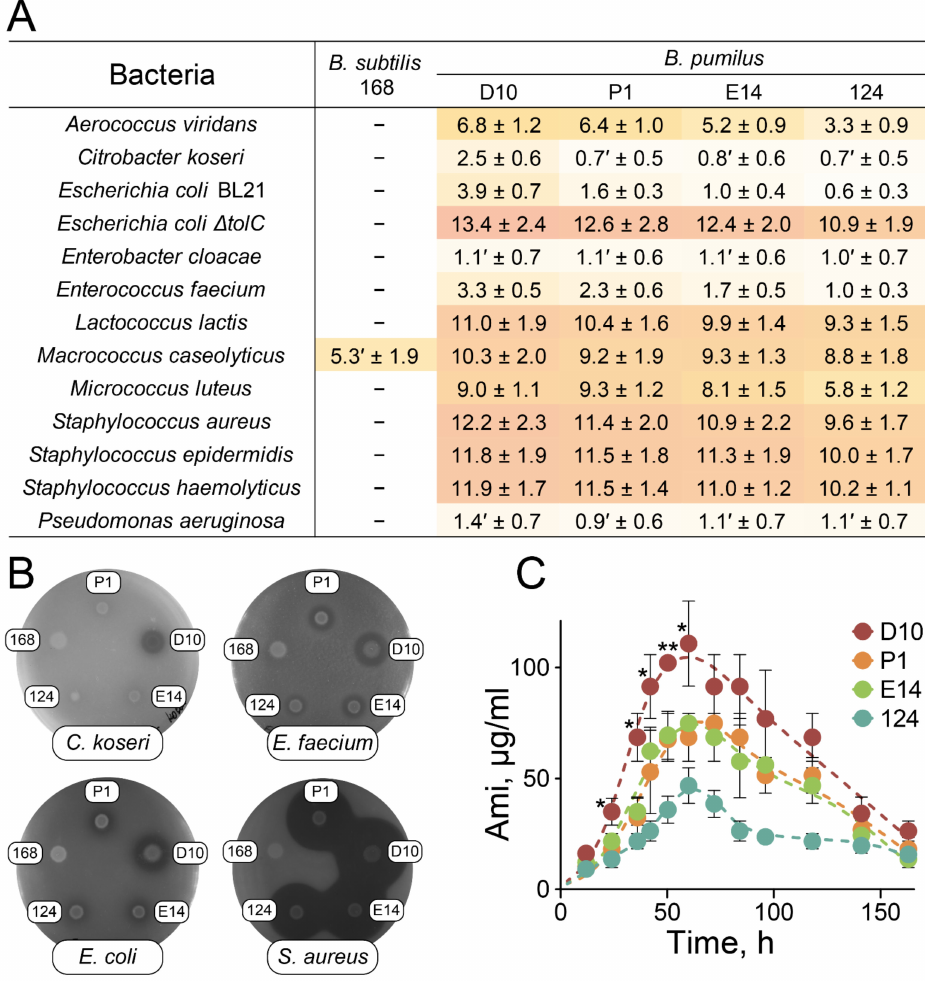
Figure 3. Antagonistic properties of B. pumilus strains and Ami production. ( A ) Diameters of clearance zones (mm) of selected B. pumilus strains (D10, P1, E14, and 124) were observed for various target pathogens using agar overlay assay. B. subtilis 168 was used as a negative control. The ( (cid:48) ) symbol corresponds to diffusive clearance zones. Clearance zones were not detected for Acinetobacter baumanii , Klebsiella pneumoniae , Morganella morganii , Salmonella enterica , and Serratia marcenscens . Heatmap indicates the diameter value. Data represent the mean of three biological replicates ± SD. ( B ) Representative agar plates with colonies of probiotic B. pumilus strains overlaid with C. koseri , E. faecium , E. coli BL21, and S. aureus . ( C ) Dynamics of Ami production by selected B. pumilus strains. Ami concentration (dots) was determined by HPLC and antibacterial activity assay of culture media in triplicate. * p < 0.05; ** p < 0.01. Data represent mean ± SD. All the selected strains efficiently inhibited the growth of Gram-positive non-spore- forming bacteria, displaying mediocre activity against Gram-negative strains (Figure